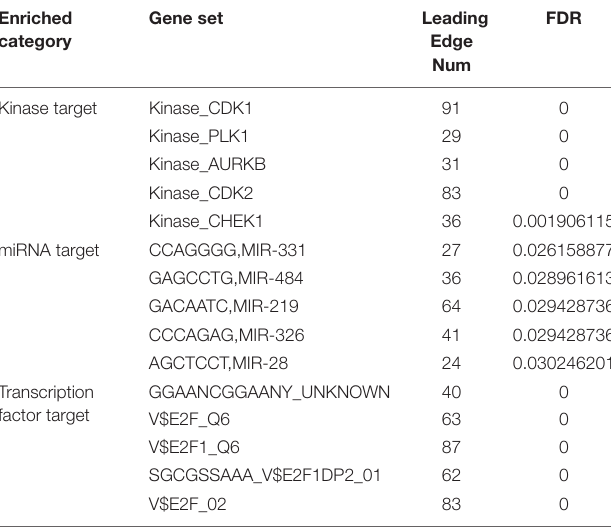
TABLE 2 | Kinases, miRNAs, and transcription factors targeting TIMM17A -associated gene networks in breast carcinoma (LinkedOmics). Enriched